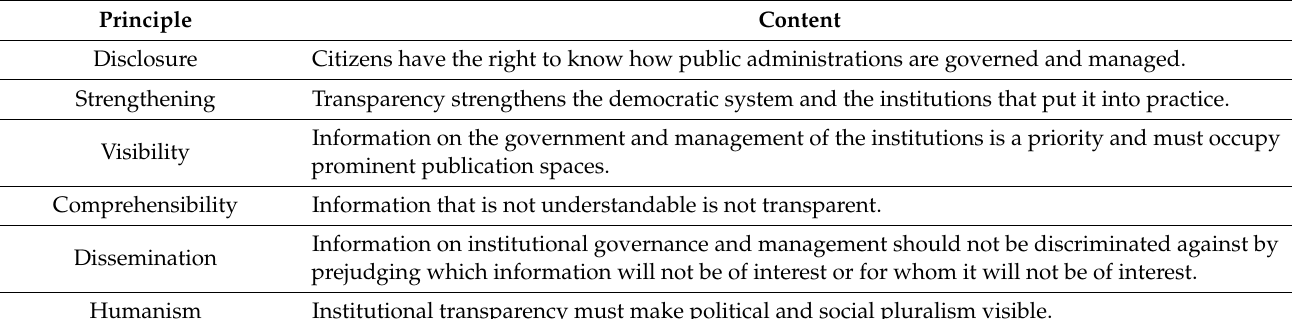
Table 2. Principles of